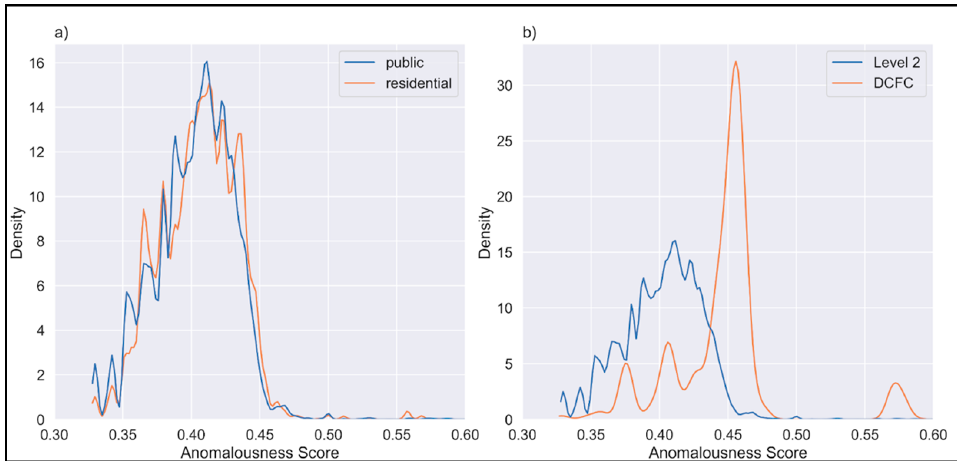
Figure 1. Distribution of anomalousness scores for ( a ) public and residential charging, and ( b ) Level 2 and DCFC.